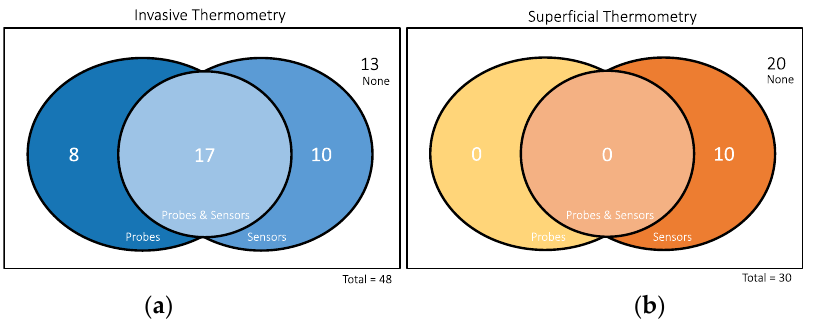
Figure 6. Number of articles reporting the number of probes and sensors for ( a ) invasive thermom ‐ etry and ( b ) superficial thermometry.